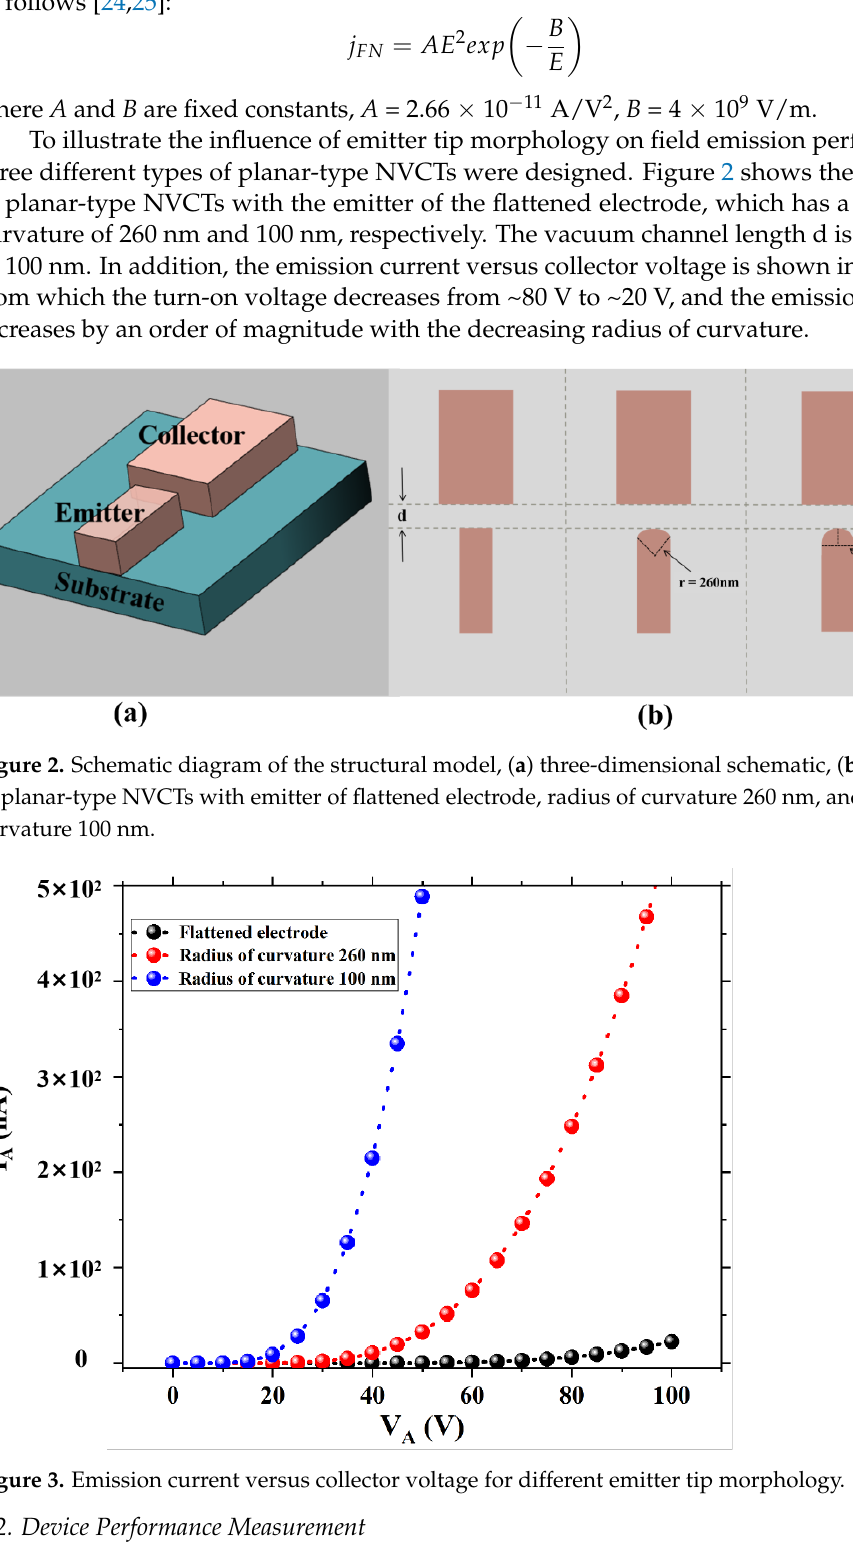
Figure 4. SEM images of (a) fabricated planar-type NVCT, and (b) the zoom-in of the nanoscale vacuum channel structure. The schematic diagram of the test setup is shown in Figure 5, where the Keithley 6487 emitter meter connects the emitter to the collector, providing the emitter-collector voltage V G and recording the emission current. The output characteristic curve is obtained by re- cording the emission current while scanning V A , with a fixed gate voltage V G . Furthermore, we can obtain a cluster of output characteristic curves by varying the V G . Furthermore, it is necessary to measure under vacuum conditions to avoid ionization. In the test, the vac- uum level in the vacuum chamber is set at around 10 −4 Pa at room temperature.